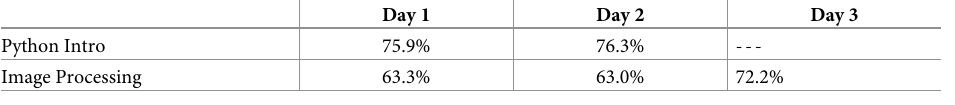
Table 6. Participant responses to the question ‘What percentage of the day’s material do you feel you have mas- tered?’ for each day of the coding workshop.